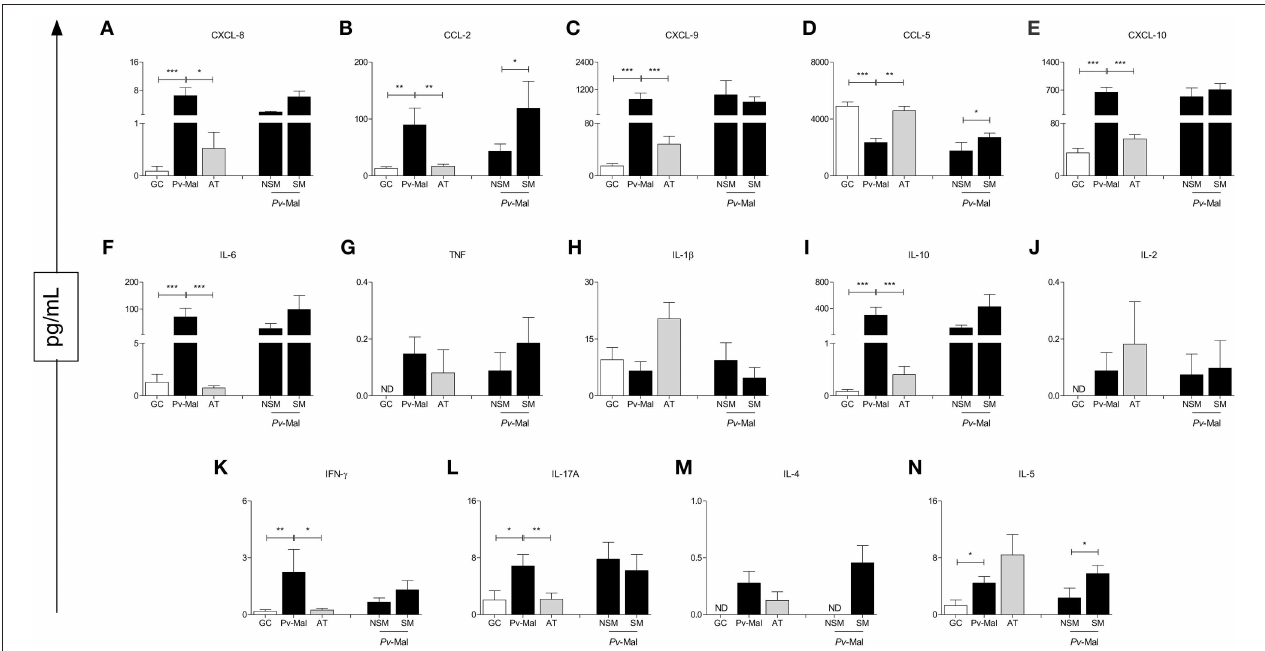
FIGURE 3 | Concentration of chemokines and cytokines in control group (white bar), Pv -malaria patients (black bar) and patients who returned 28 days after treatment, understood as the period of convalescence (gray bar). In addition, analysis of the chemokines and cytokines concentrations of Pv -malaria patients at the time of diagnosis who did not Self-Medicate (NSM) and Self-Medicated (SM). * p < 0.05, ** p < 0.01, *** p < 0.0001 between groups studied. ND = Concentration not detected. The quantifications of these chemokines and cytokines were measured using Cytometric Bead Array (CBA) and